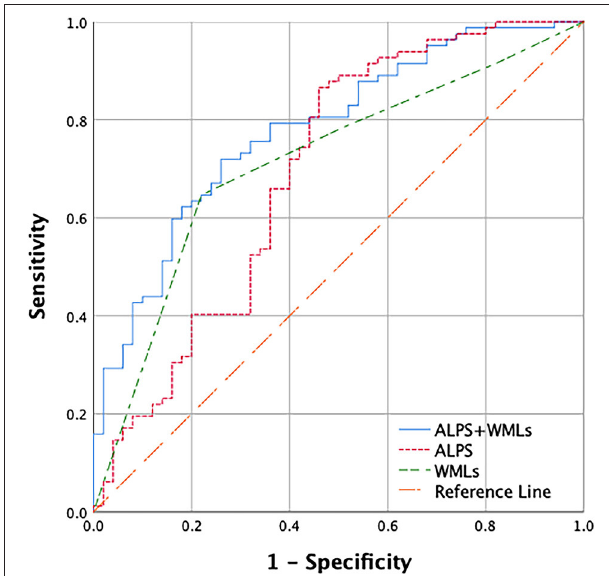
FIGURE 2 | Receiver operating characteristic (ROC) curves used to predict cerebral small vessel disease (CSVD) cognitive impairment with the combination of the diffusion tensor image analysis along the perivascular space (ALPS) index and WMLs. Only the ALPS index and white matter lesions (WMLs) remained in the backward stepwise logistic regression model. The area under the receiver operating characteristic (AUROC) of the ALPS index and WMLs combined is 0.780 (blue), the AUROC of WMLs alone is 0.714 (green), and the AUROC of the ALPS index alone is 0.694 (red).